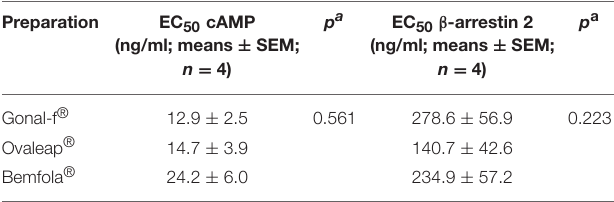
( Table 5 ; 140.7 ± 42.6–278.6 ± 56.9 ng/ml range; Kruskal- Wallis test, p ≥ 0.05; n = 4; Figure 2B ), consistent between